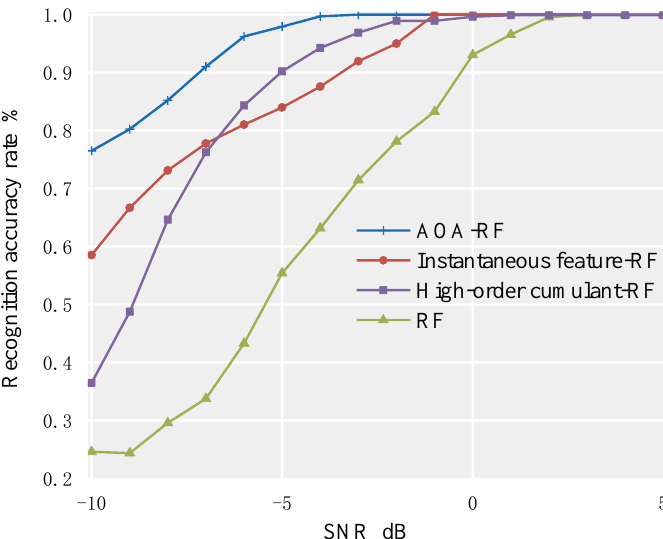
Figure 11. Comparison of average recognition rate between AOA–RF algorithm and traditional method.